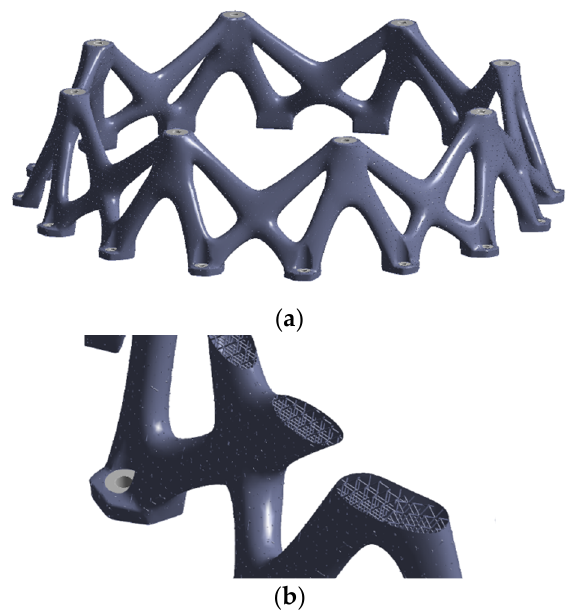
Figure 9. Lattice-filled design of the aircraft support (inner diameter of 360 mm, outer diameter of 400 mm, height of 100 mm): ( a ) overall view; ( b ) partial cross-section view.